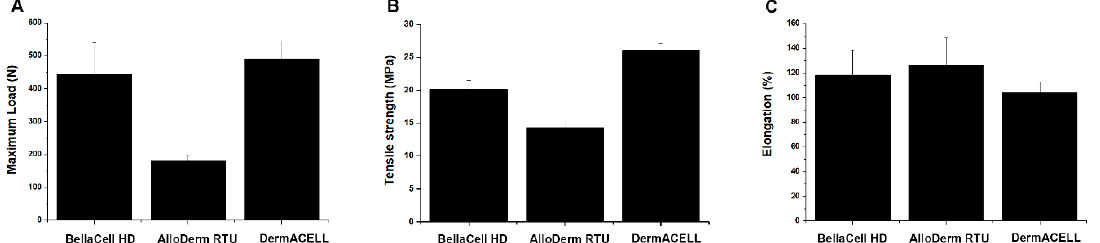
Figure 3. Cytotoxicity assay. ( A ) Cell viability was assessed by an MTT assay. ( B ) Cell morphology was observed under the light microscope at 200× magnification. Cytotoxicity of cell growth and cell viability in the three tissues. Figure 3A shows 90% cell viability and no cytotoxicity. In figure 3B, cells